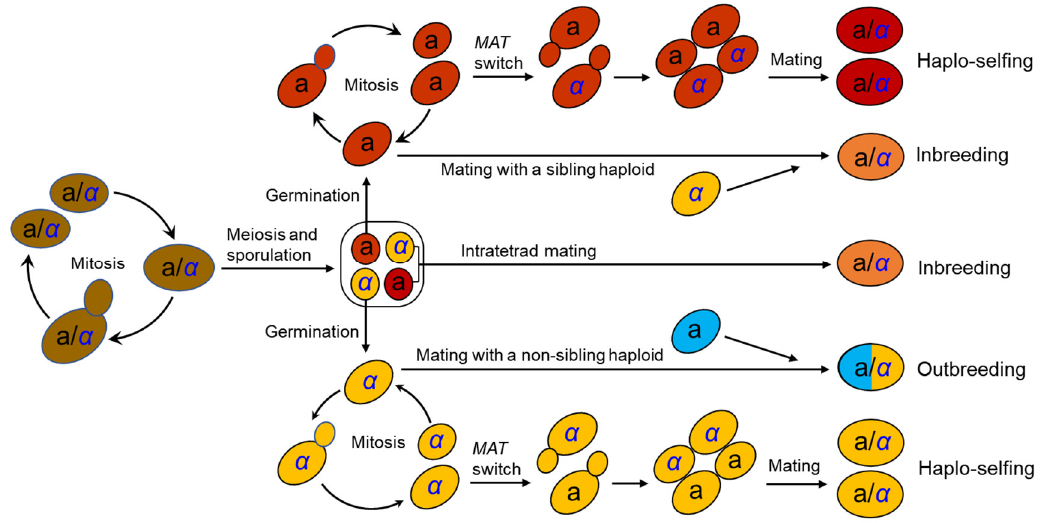
Figure 1. The life cycle and mating behaviors of S. cerevisiae . Vegetative cells are usually diploid and reproduce asexually by budding (mitosis). A diploid cell undergoes meiosis and sporulation due to nitrogen starvation and results in the formation of a tetrad with four ascospores, which either undergo intratetrad mating to form a diploid cell, or germinate to form haploid cells. A haploid cell either reproduces by budding, or mates with a sibling or non-sibling haploid with an opposite mating type to form a diploid cell, or undergoes haplo-selfing or autodiploidization through a process known as mating-type ( MAT ) switch to restore the diploid phase.